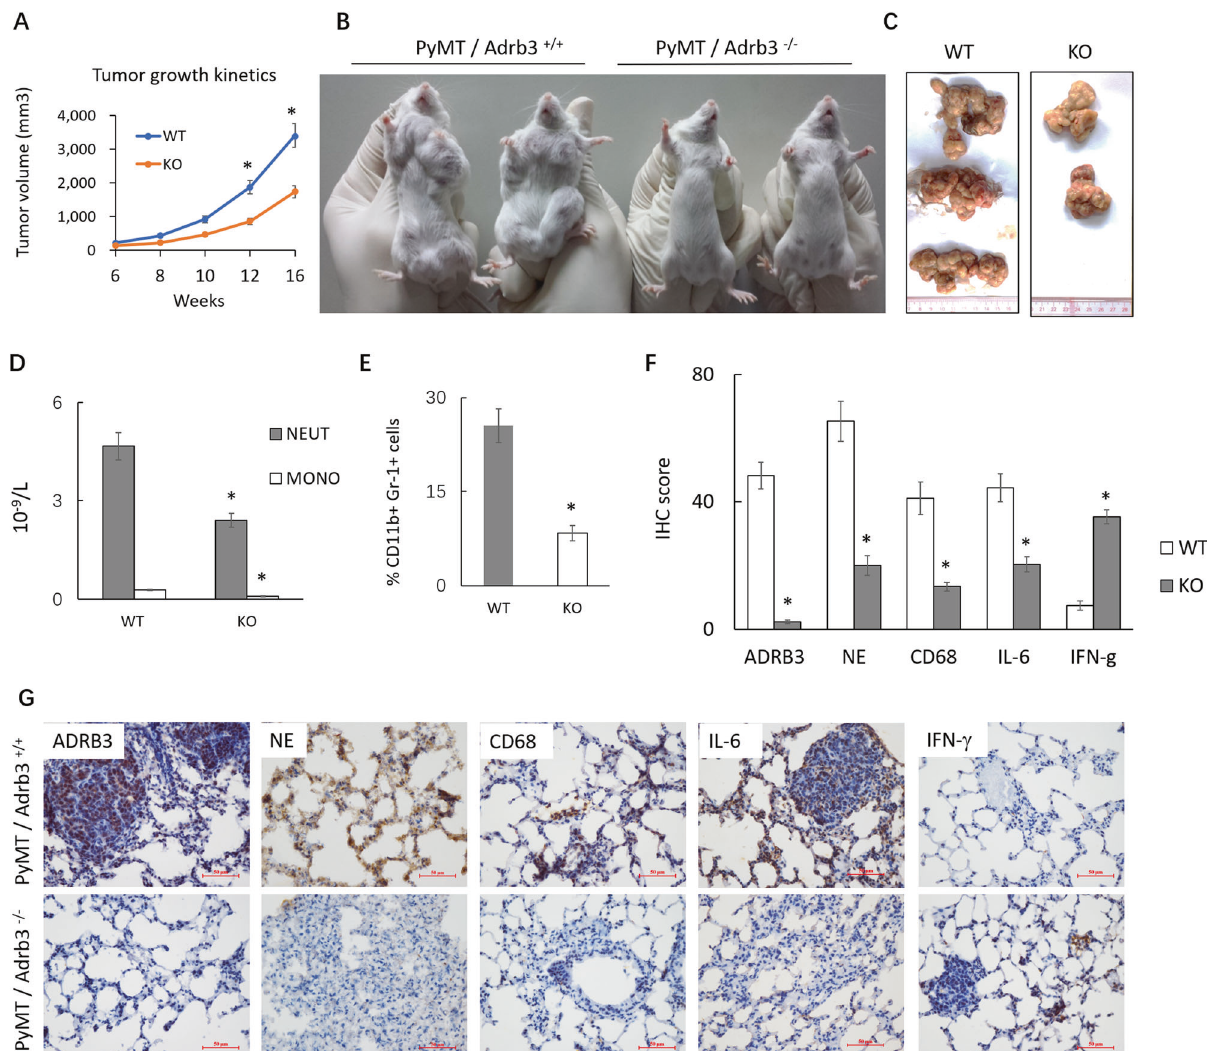
Fig. 5 ADRB3 loss impairs MMTV-PyMT tumor formation and metastasis. A Tumor growth kinetics ( n = 10 WT, n = 10 KO mice, 3 tumors per mouse), * P < 0.05. Two-way ANOVA test with Holm- Š idák multiple-comparisons test. B Observation of breast tumor of 18-week-old PyMT- ADRB3 + / + and PyMT-ADRB3 -/- mice. C The photograph of the excised tumors. D Numbers of neutrophils, monocytes and lymphocytes in the blood of 18-week-old PyMT-ADRB3 + / + and PyMT-ADRB3 -/- mice. EDTA anti-coagulated blood samples were used to obtain a complete blood count with automated hematology analyzer. E Frequencies of CD11b + Gr-1 + cells in spleens from PyMT-ADRB3 + / + and PyMT-ADRB3 -/- mice, * P < 0.05. F , G Immunohistochemical analysis of ADRB3, neutrophil elastase (NE), CD68, IL-6, and IFN- γ and Rictor expression in lung tissues (×200 magni fi cation), * P < 0.05 compared with PyMT-ADRB3 + / +